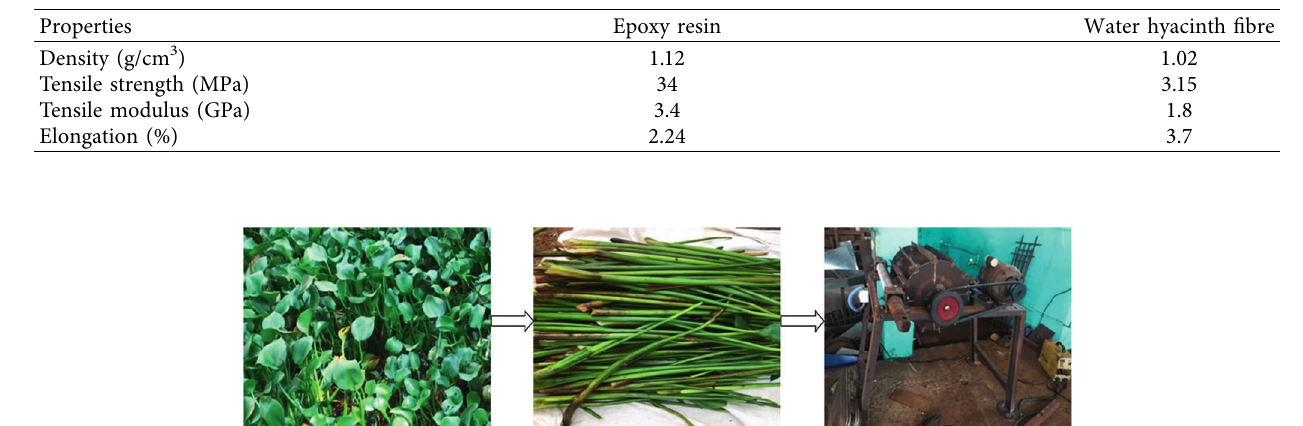
Table 1: Mechanical properties of epoxy resin and water hyacinth plant